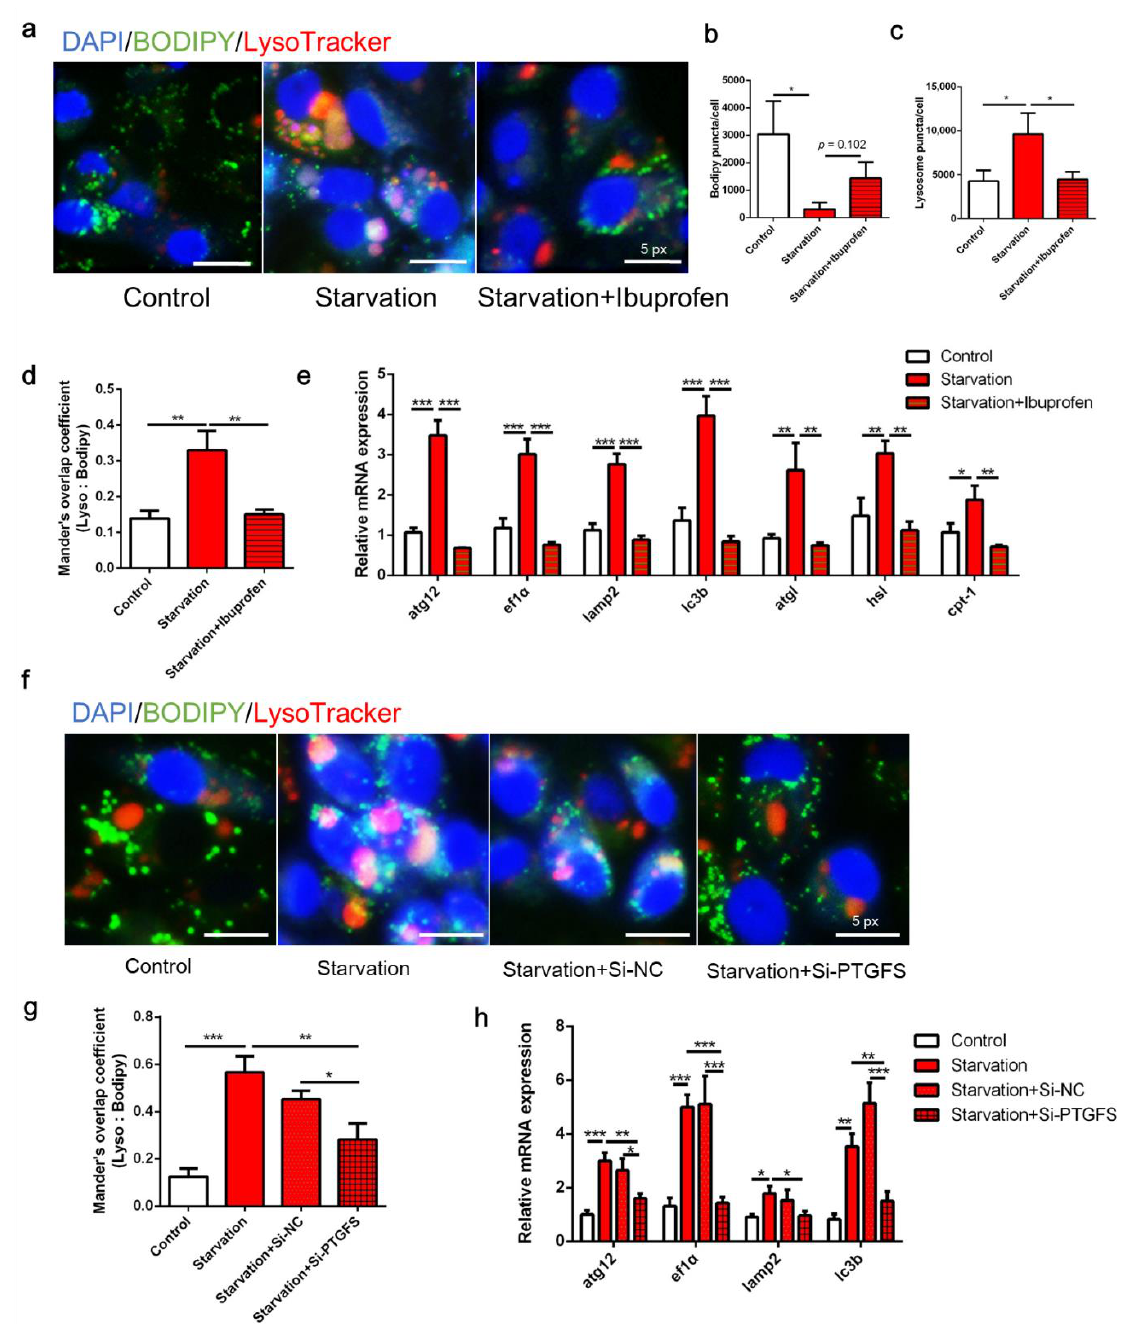
Figure 3. Effects of cyclooxygenase (COX) pathway inhibition on serum starvation-induced au- tophagy and lipid droplet (LD) degradation in zebrafish liver cells. ( a – e ) Cells were administered the COX inhibitor ibuprofen (10 µ M) and then serum-deprived for 24 h. ( f – h ) Cells were pre-interfered with Si-NC or Si-PTGFS then treated with serum deprivation for 6 h. LDs were stained with BODIPY (green), nuclei were stained with DAPI (blue), and lysosomes were stained with LysoTracker (red). LD and lysosome puncta per cell as well as Mander’s overlap coefficient were measured using Image J ( n = 3). Relative expression of autophagy-related genes was tested using qRT-PCR ( n = 3). atg12, autophagy-related 12; ef1 α , elongation factor 1 α ; lamp2, lysosomal-associated membrane protein 2; lc3b, microtubule-associated protein 1 light chain 3b; atgl adipose tissue lipase; hsl, hormone-sensitive lipase; cpt-1, carnitine palmitoyltransferase 1. Statistical significance is denoted with asterisks as follows: * p < 0.05; ** p < 0.01; *** p <